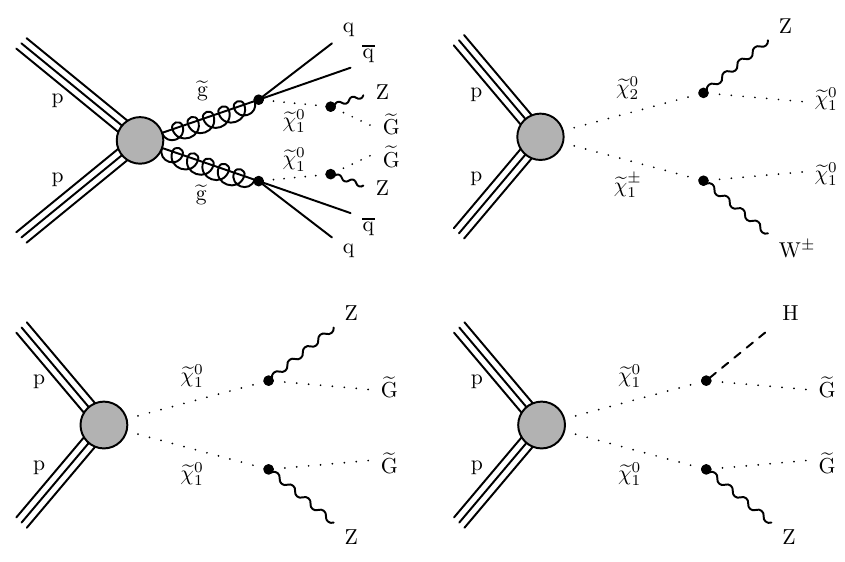
Figure 1 . Diagrams for models with decays containing at least one dilepton pair stemming from an on-shell Z boson decay studied in this analysis. The model targeted by the strong-production search is shown in the upper left. The three other diagrams correspond to EW production of chargino- neutralino or neutralino-neutralino pairs. All the diagrams containing a gravitino ( gauge-mediated SUSY breaking (GMSB) models.